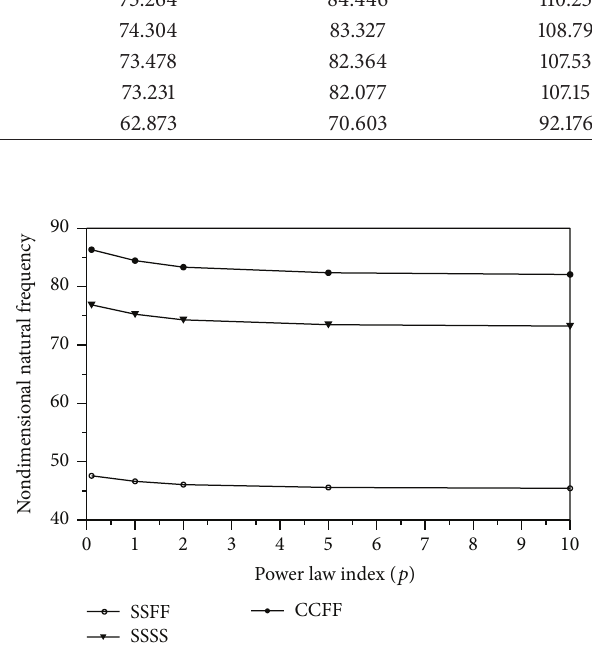
Figure 7: Effect of power law index on the nondimensional natural frequency of FGM plate with arbitrary